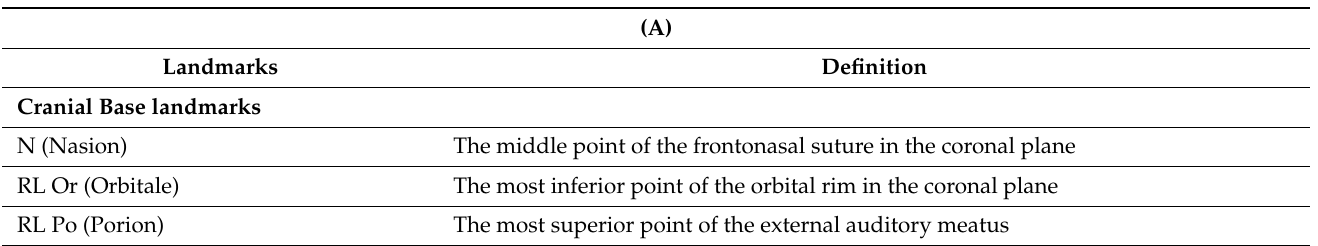
Table 1. ( A ). Definitions of three-dimensional landmarks. ( B ) Definitions of three-dimensional